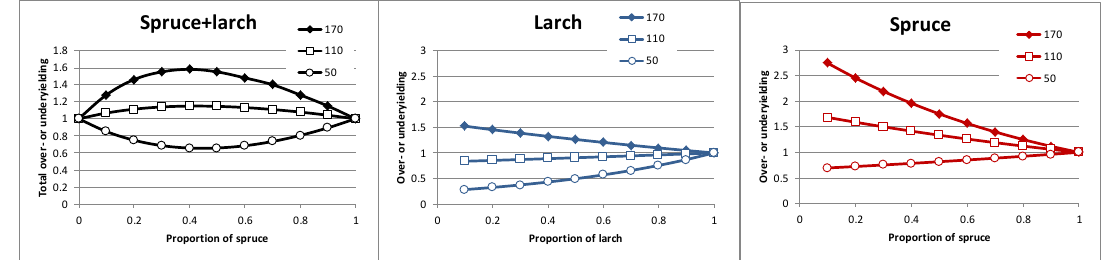
Figure 5. The Kelty diagrams as they result from Equation (6), with coefficients from Table 6.